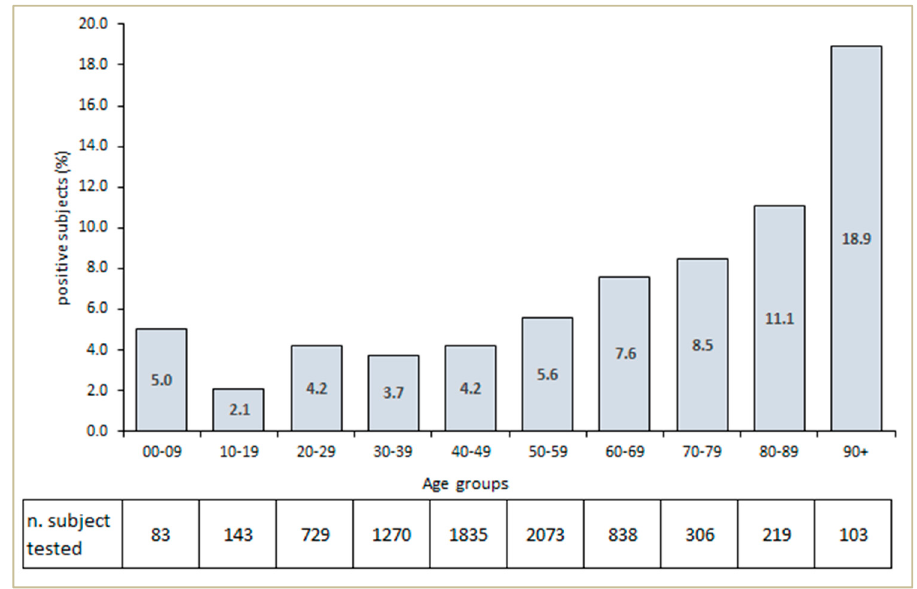
Figure 2. Number of subjects tested and percentage of subjects who tested positive for SARS-CoV-2 and attended the Advanced Triage Unit according to age group.